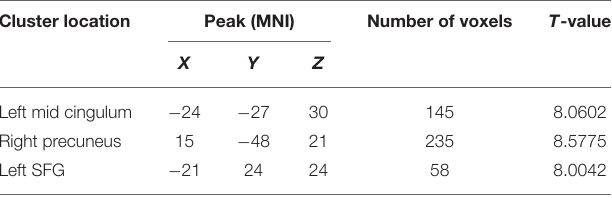
Frontiers in Neurology |